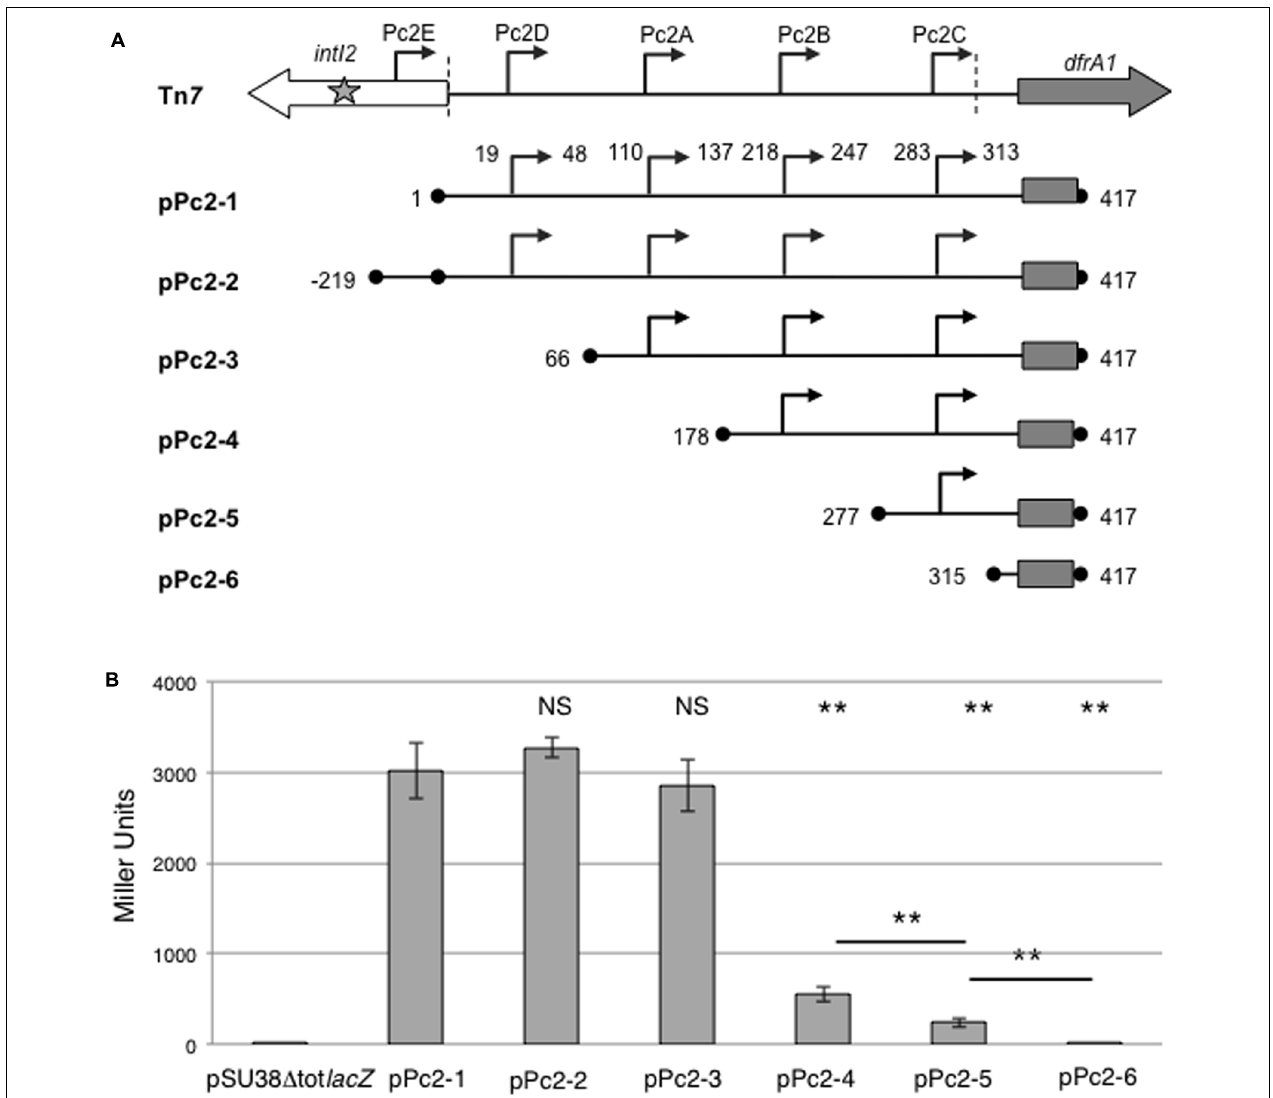
FIGURE 3 | Activity of putative class 2 integron Pc promoters. (A) Schematic representation of the class 2 integron carried on Tn 7 and Pc- lacZ translational fusions with the entire or partially deleted attI2 site carried on plasmids pPc2-1–pPc2-6. Boundaries of the cloned fragment are indicated by black dots and numbered according to its position in the pPc2-1 fragment (417 bp long). The cloned portion of the dfrA1 coding sequence is indicated by a rectangle. Broken arrows represent each putative Pc2 promoter. The boundaries of the attI2 region (nt4-nt314) are marked by vertical dotted lines. (B) The contribution of each putative Pc2 promoter (Pc2A–Pc2E) was estimated by measuring β -galactosidase activity from each plasmid. pSU38 (cid:49) tot lacZ is the empty control plasmid. At least five independent assays were performed for each construct. Error bars indicate the standard deviation. P -values (ANOVA and HSD Tukey’s test) for comparison with pPc2-1 (on the top) and between constructs are indicated: ∗∗ p < 0.01, NS p >